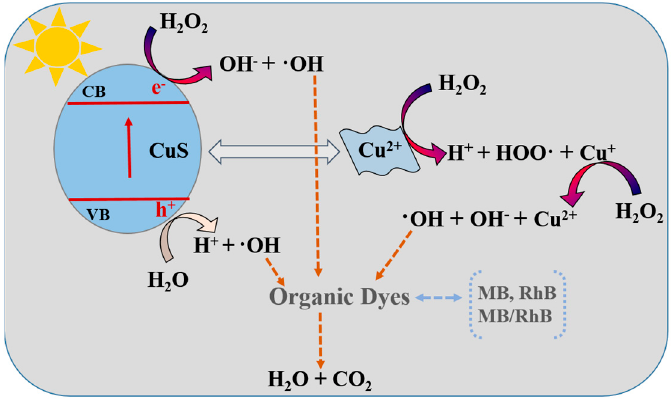
Figure 7. A plausible mechanism for the photocatalytic degradation of organic dyes over CuS under simulated solar light irradiation.